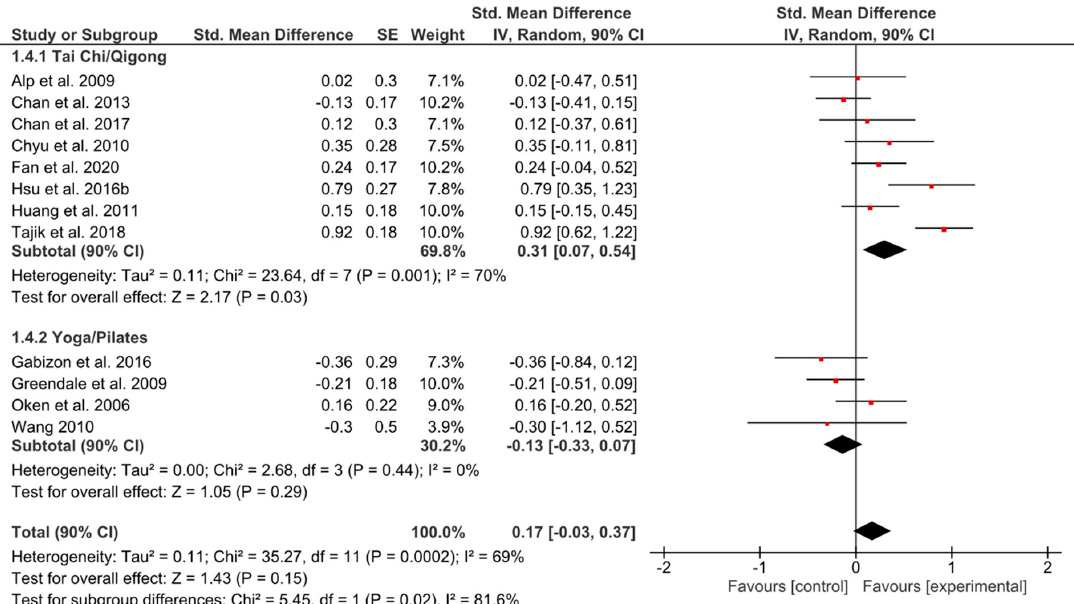
Figure 5. Standardized mean effects of mind–body interventions on social functioning (subscale of quality of life) compared to a non-exercise control group. Data are separately presented for Tai Chi/Qigong and Yoga/Pilates. SE: standard error; IV: inverse variance model; CI: confidence interval; Std.: standardized.